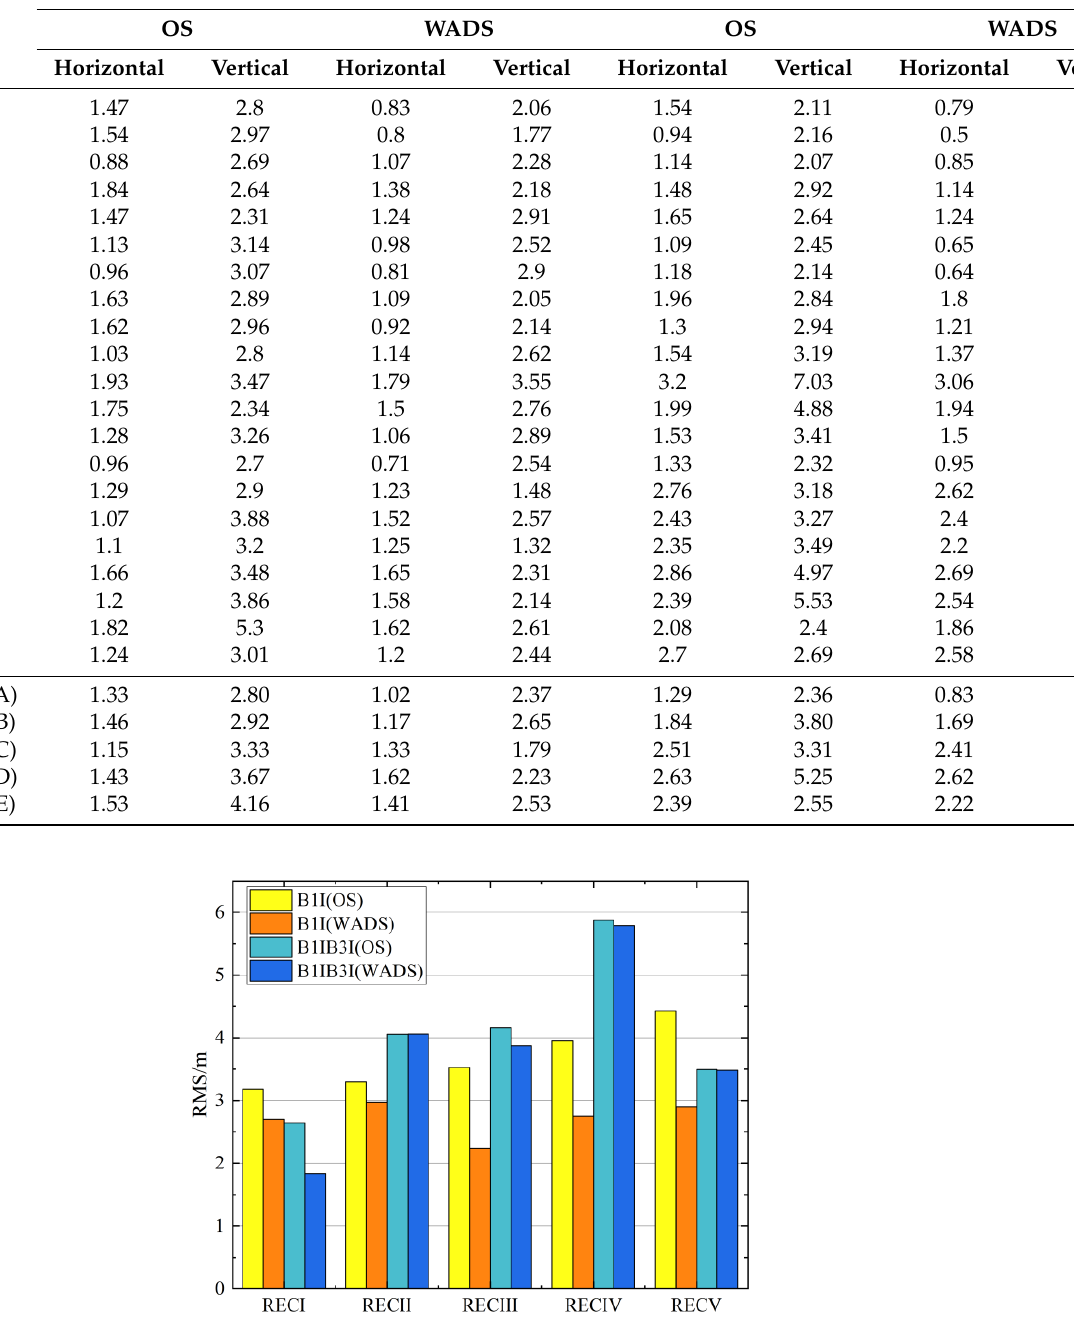
Figure 9. The positioning accuracy in the B1I and the B1I/B3I IF combination of the five types of receivers in the OS and the WADS. Table 5. The single- and dual-frequency positioning accuracy in the BDS OS and the WADS (unit: meter).